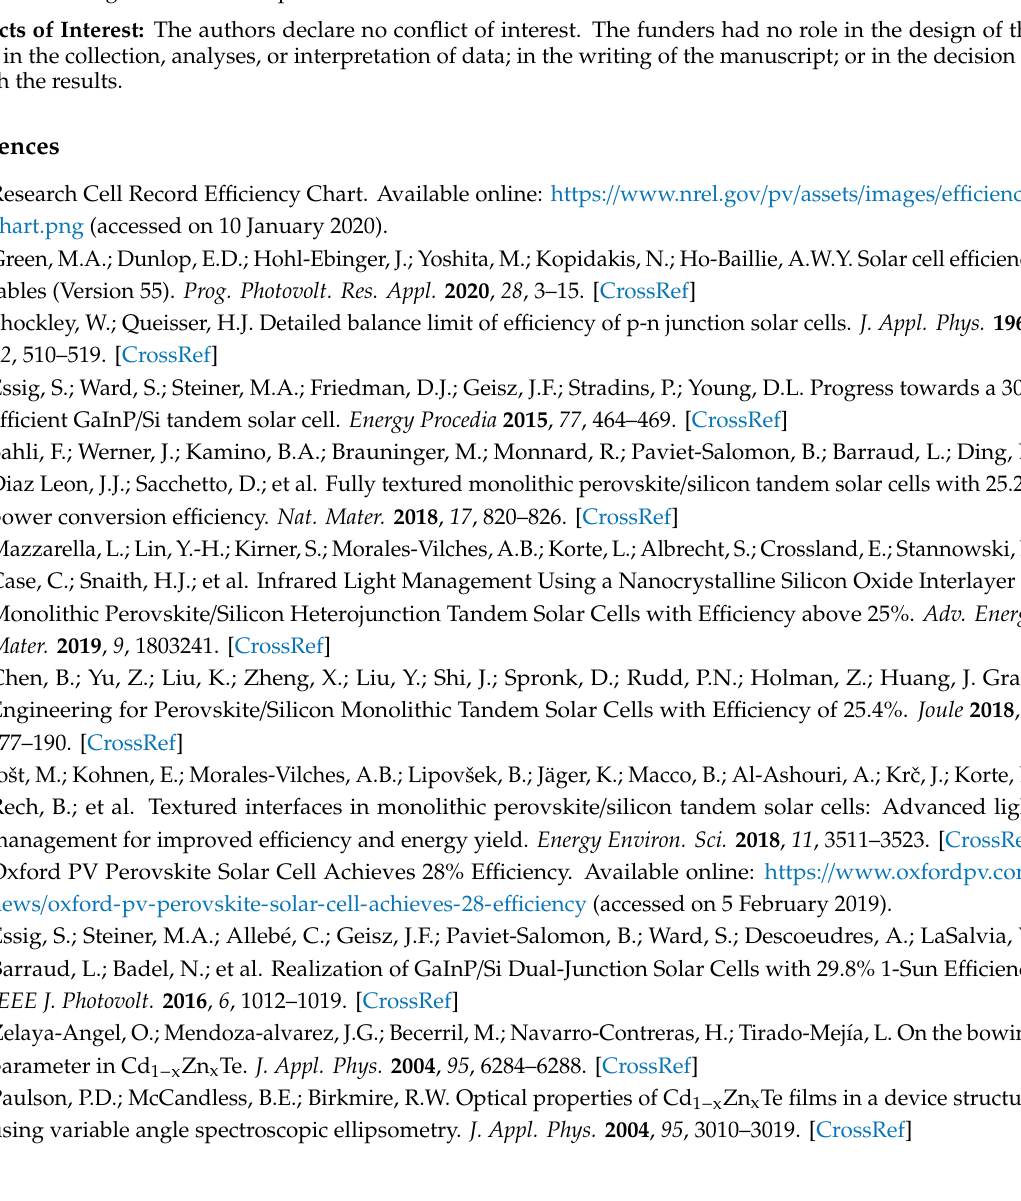
Figure S1: Single-pass absorption spectra for 3 µ m thick top cell active absorber (CdTe, C 0.6 Z 0.4 T and ZnTe) obeying the Beer-Lambert Law for the incident light as a function of wavelength, Figure S2: Refractive index (n) and extinction coe ffi cient (k) of materials used in this study, Figure S3: Schematic of the tandem device with inverted top cell structure. Front and rear TCOs are ITO; ETL is CdS; HTL is MoO x ; and an index matching glue is employed between two cells. EVA is used to protect IBC Si cell contacts; glass is employed as the substrate, Figure S4: CdTe / IBC Si tandem e ffi ciency as a function of ( a ) lifetime for three surface recombination velocities (10, 50 and 500 cm / s) for a 3 µ m CdTe absorber and ( b ) series resistance for four shunt resistances (Infinite, 5k, 2k and 1k Ω / cm 2 ) for a lifetime of 5 ns and surface recombination velocity of 500 cm / s. CdS is used as the ETL, Figure S5: Top cell J-V curves of selected C 1 − x Z x T cases (x = 0.4, 0.6) with 50 nm ETL of CdS and MZO, Table S1: Simulation parameters of solar cells used in SCAPS